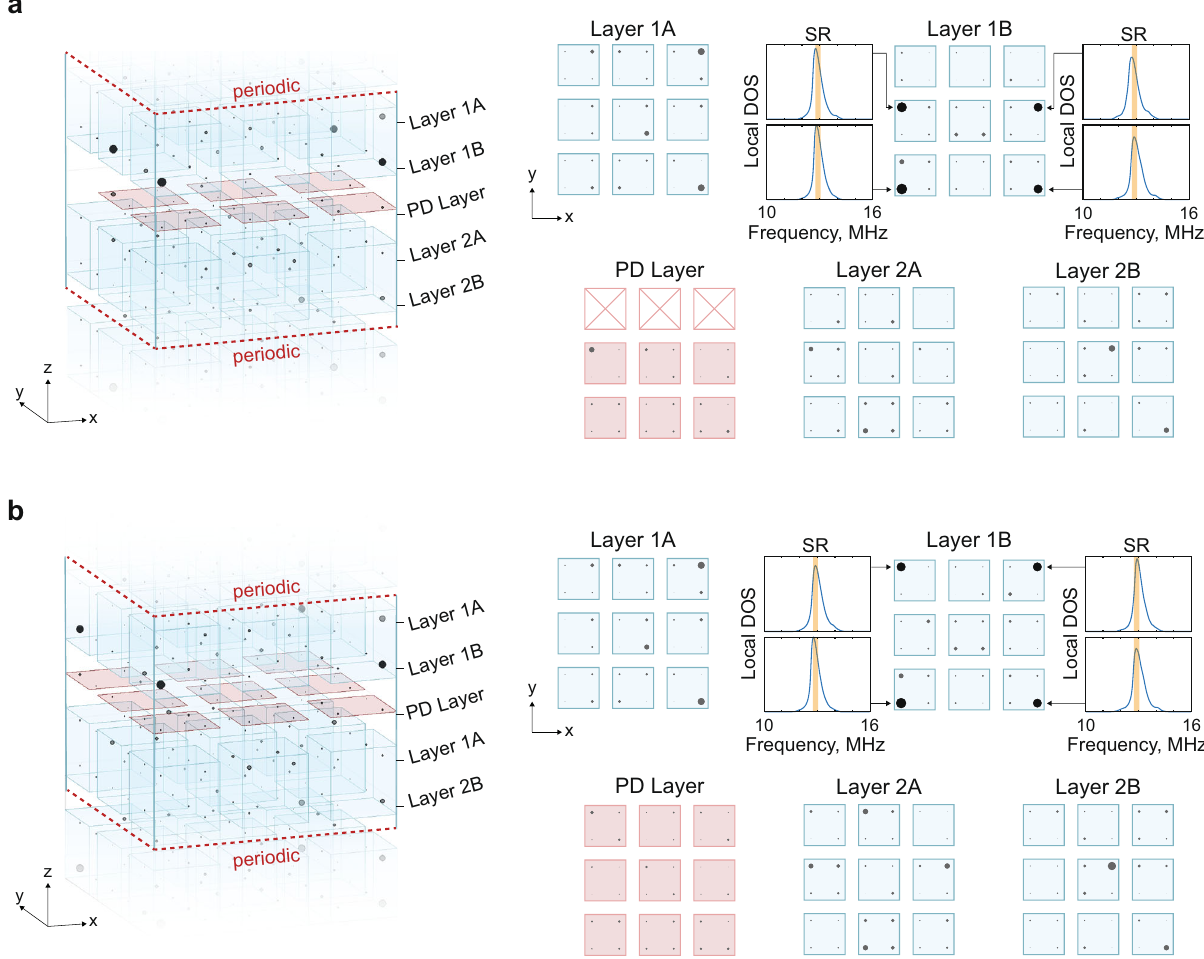
Fig. 4 Octupolar TCI partial dislocation experiments. a Spatial map of mode density at each site over the spectral range (SR) of 12.75 MHz – 13.05 MHz in an octupole TCI (blue unit cells) with an bulk-terminated partial dislocation (red unit cells). In the spatial map, each site is represented by a circle with radius proportional to the local mode density over the selected SR. The local DOS is shown in the inset for the sites with the largest mode density, and the SR is highlighted in orange. b same as ( a ), but for a boundary-terminated partial dislocation. Complete local DOS measurements for all sites in ( a ) and ( b ) are presented in Supplementary Figures S11 and